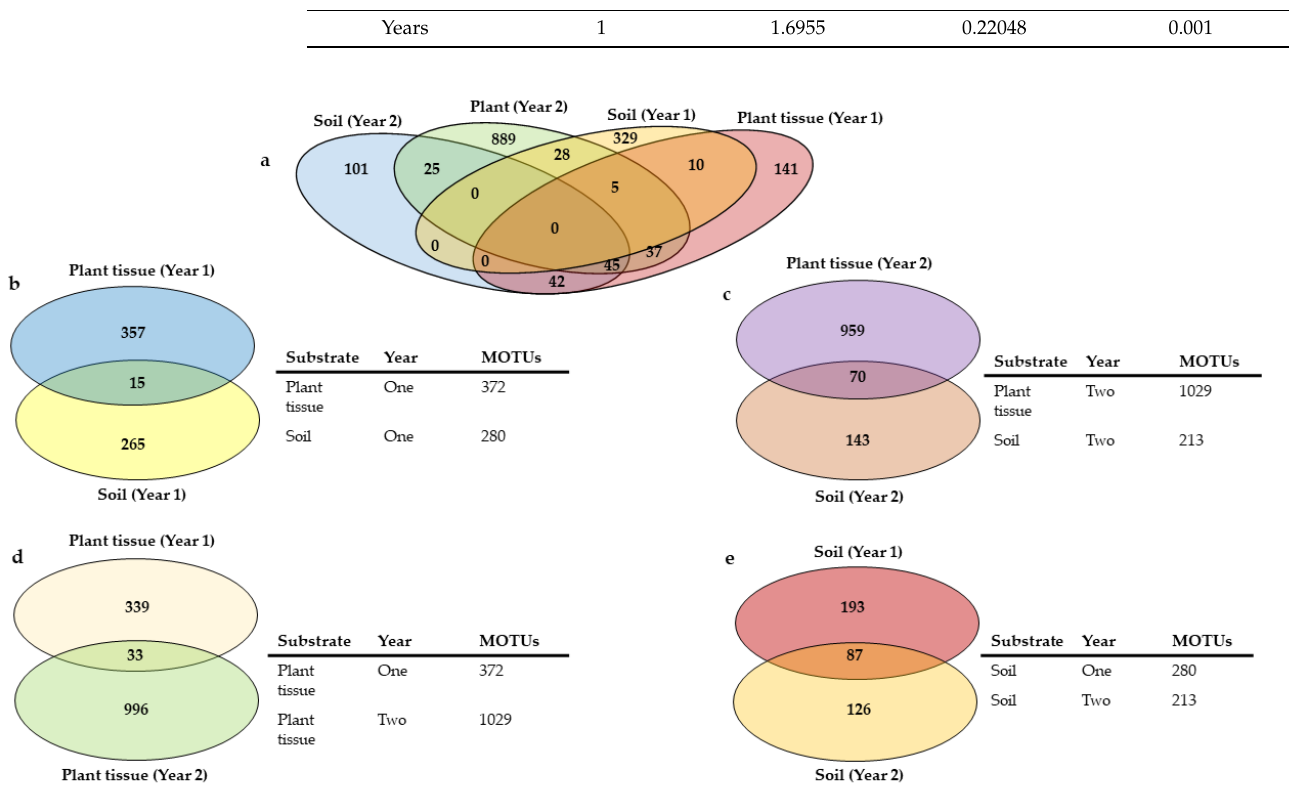
Figure 3. Numbers of unique and shared fungal MOTUs in combined plant tissues and soils over two years overall ( a ) as well as plant tissue and soil of year one ( b ), plant tissue and soil of year two ( c ), plant tissue from year one and two ( d ), and soils from year one and two ( e